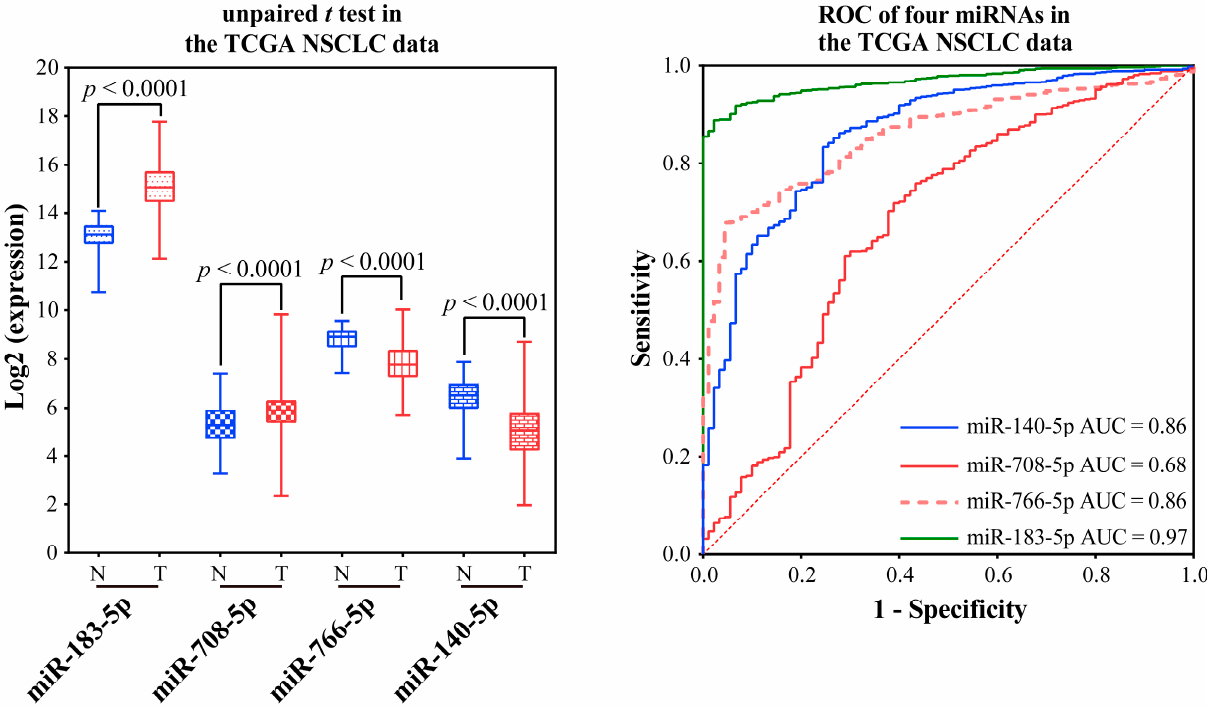
Figure 7. Validation of miRNA markers in unpaired NSCLC and normal samples in TCGA. The blue box indicates the normal samples, while the red box indicates the tumor samples.